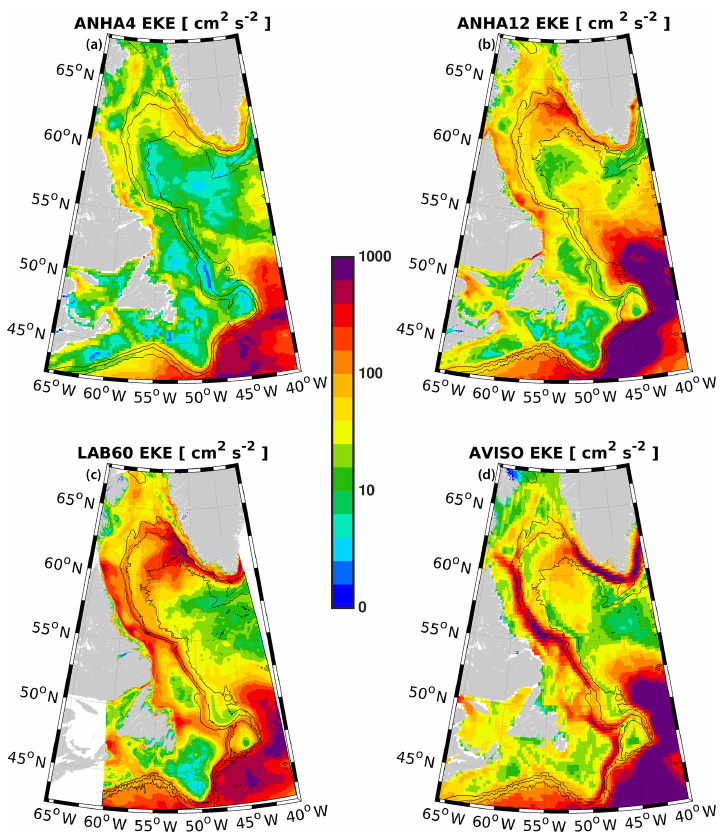
Figure 5. Eddy kinetic energy (EKE), as calculated from geostrophic velocities resulting from the sea level height anomaly, are shown for (a) ANHA4, (b) ANHA12, and (c) our LAB60 simulation, from 2004 to 2013. Observations via AVISO are identified in panel (d) . The 1000, 2000, and 3000m isobaths are shown by the black contour lines. A log scale was used for clarity.